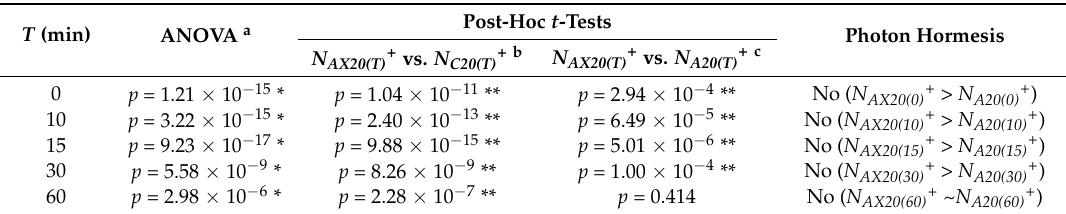
Table 2. ANOVA and post-hoc t -test results obtained among N AX20(T) + , N A20(T) + , and N C20(T) + , with time gaps T = 0, 10, 15, 30, or 60 (min) between the alpha-particle and X-ray irradiations, and with apoptotic counts determined at H = 20